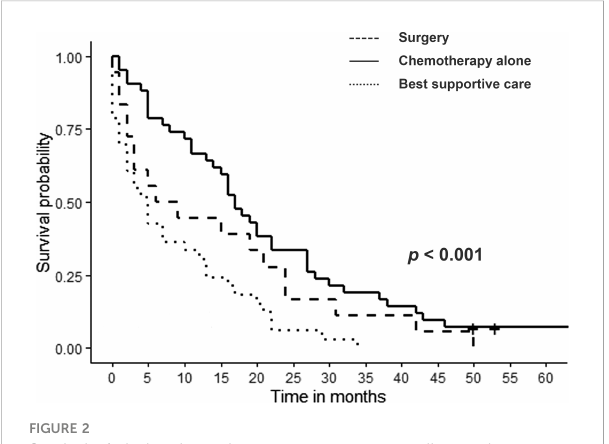
FIGURE 2 Survival of cholangiocarcinoma recurrence according to the treatment received. Surgery or systemic chemotherapy only vs best supportive therapy (p<0.001). Surgery vs systemic chemotherapy only (p=0.308).